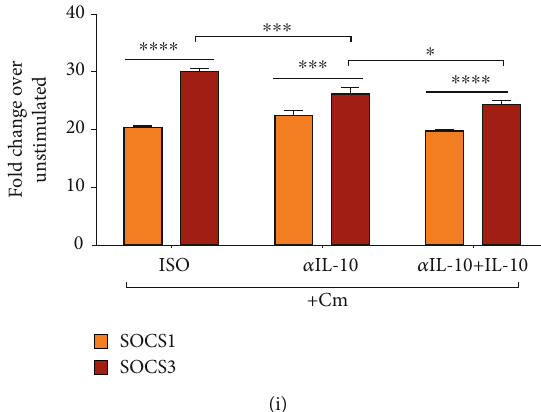
Figure 4: Endogenously produced IL-10 regulates in fl ammatory mediators and SOCS expression in chlamydial-stimulated macrophages. Macrophages (10 6 /mL) were stimulated for 24 h with rMOMP (10 μ g/mL) or Cm (MOI of 2) to quantify the production of endogenously produced IL-10 in supernatants by ELISA (A). Macrophages were pre-incubated with neutralizing Ab ( α IL-10) to IL-10 (25 μ g/mL) for 30min before adding rMOMP (10 μ g/mL) or Cm (MOI of 2) for an additional 24h. Normal rat IgG1 Ab served as the isotype control (ISO). Post-stimulation, supernatants were collected to quantify IL-6 (B, F), IL-12p40 (C), TNF (D), and CCL5 (E, G) by speci fi c ELISAs and RNA was isolated to quantify the mRNA gene transcripts of SOCS1 and SOCS3 (H-I) by TaqMan qRT-PCR. An asterisk indicates a signi fi cant di ff erence ( P < 0.05), and P values were calculated as described in Figure 1 legend. Each bar represents the mean ± SD of samples run in triplicates, and each experiment was repeated at least 3